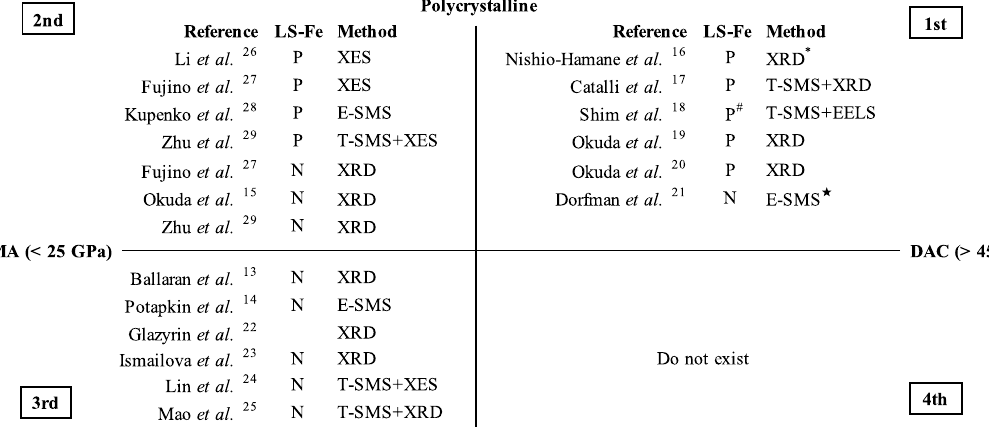
Figure 1. The spin state of Fe in (Fe,Al)-bearing bridgmanite compiled in a two-dimensional diagram with the x-axis the sample synthesis pressure and the y-axis the sample grain size. 1st and 2nd quadrants, studies used a multigrain sample, 3rd and 4th quadrants, studies used a single-crystal sample. 1st and 4th quadrants, sample synthesized in a DAC, 2nd and 3rd quadrants, used a sample pre-synthesized in a MA. Numbers in the table denote the quadrants. * : discussed in Fujino et al. 20 . # : lack clear evidence from their synchrotron Mössbauer spectroscopy (SMS) results but has suggested being present from their Electron Energy-Loss Spectroscopy (EELS) results. *: hiroseite with almandine composition. P present; N no evidence. T- and E-SMS, time-